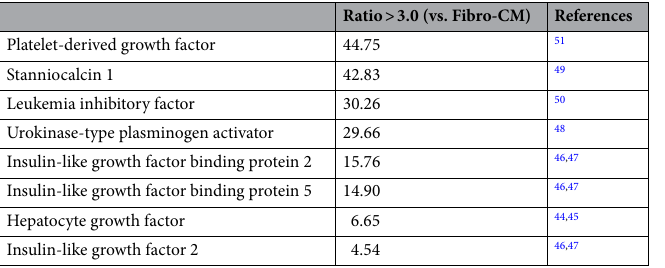
Table 1. Therapeutic factors of SHED-CM for IR-induced salivary gland injury. CM, conditioned medium; IR, irradiation; SHED, stem cells from human exfoliated deciduous